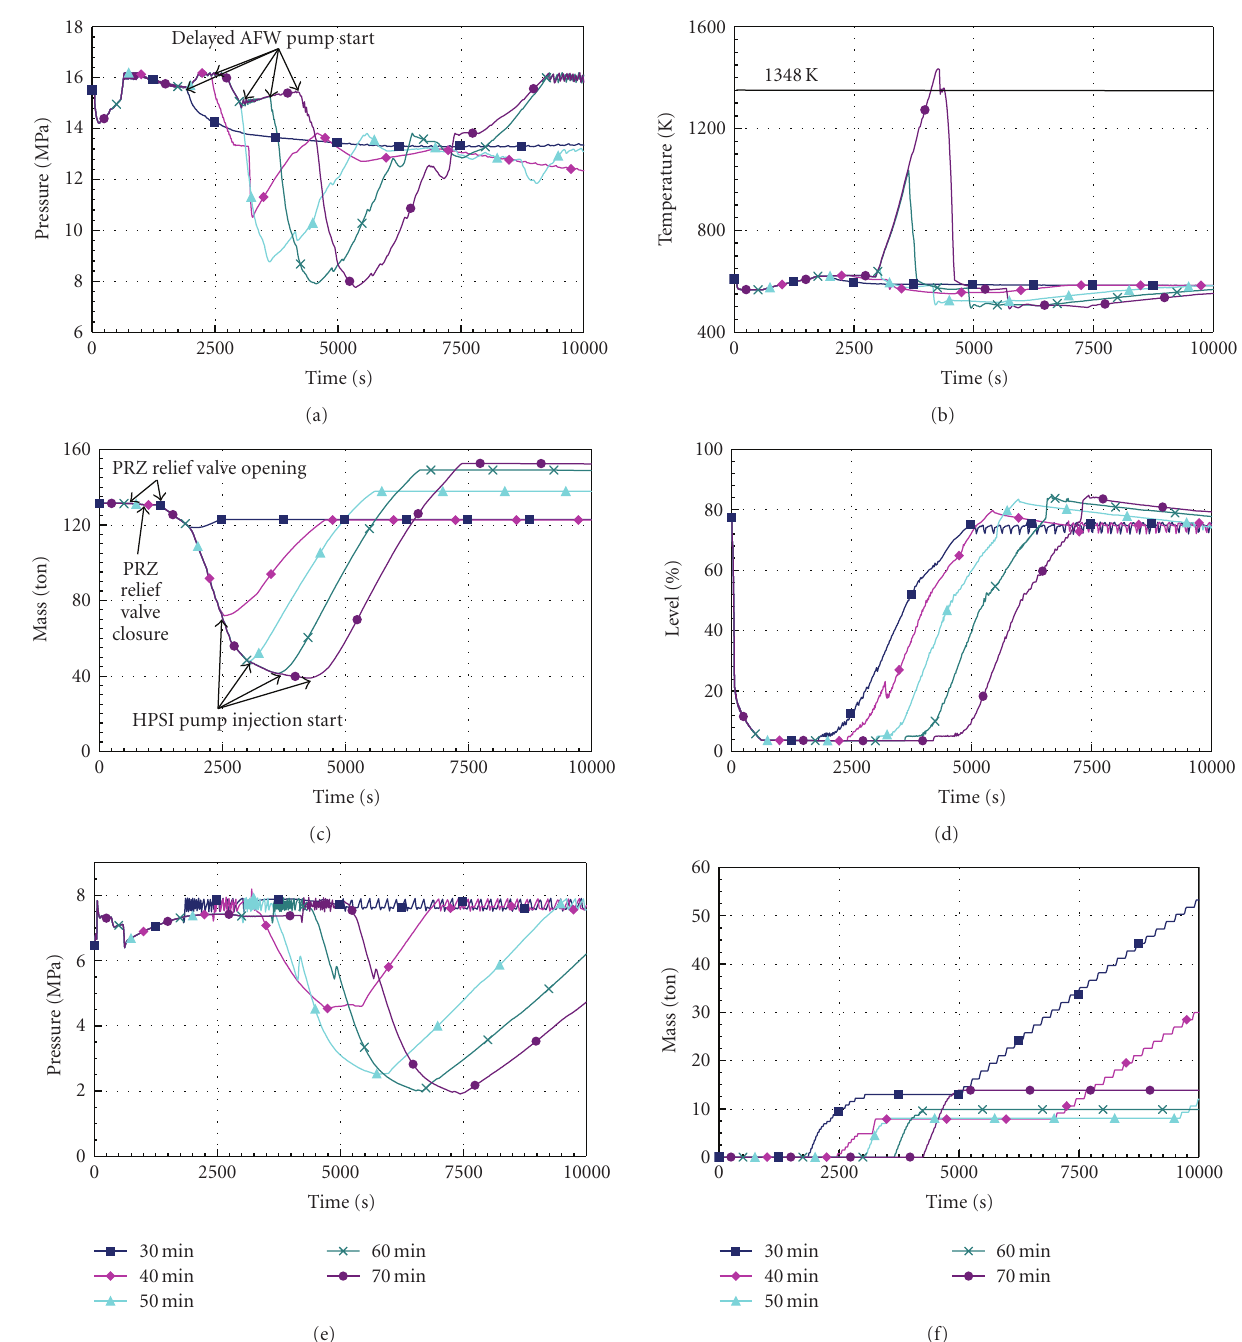
Figure 5: LOFW transient: (a) RCS pressure, (b) core cladding temperature, (c) RCS mass inventory, (d) SG no. 1 wide range level, (e) SG no. 1 pressure, (f) mass discharged through SG no. 1